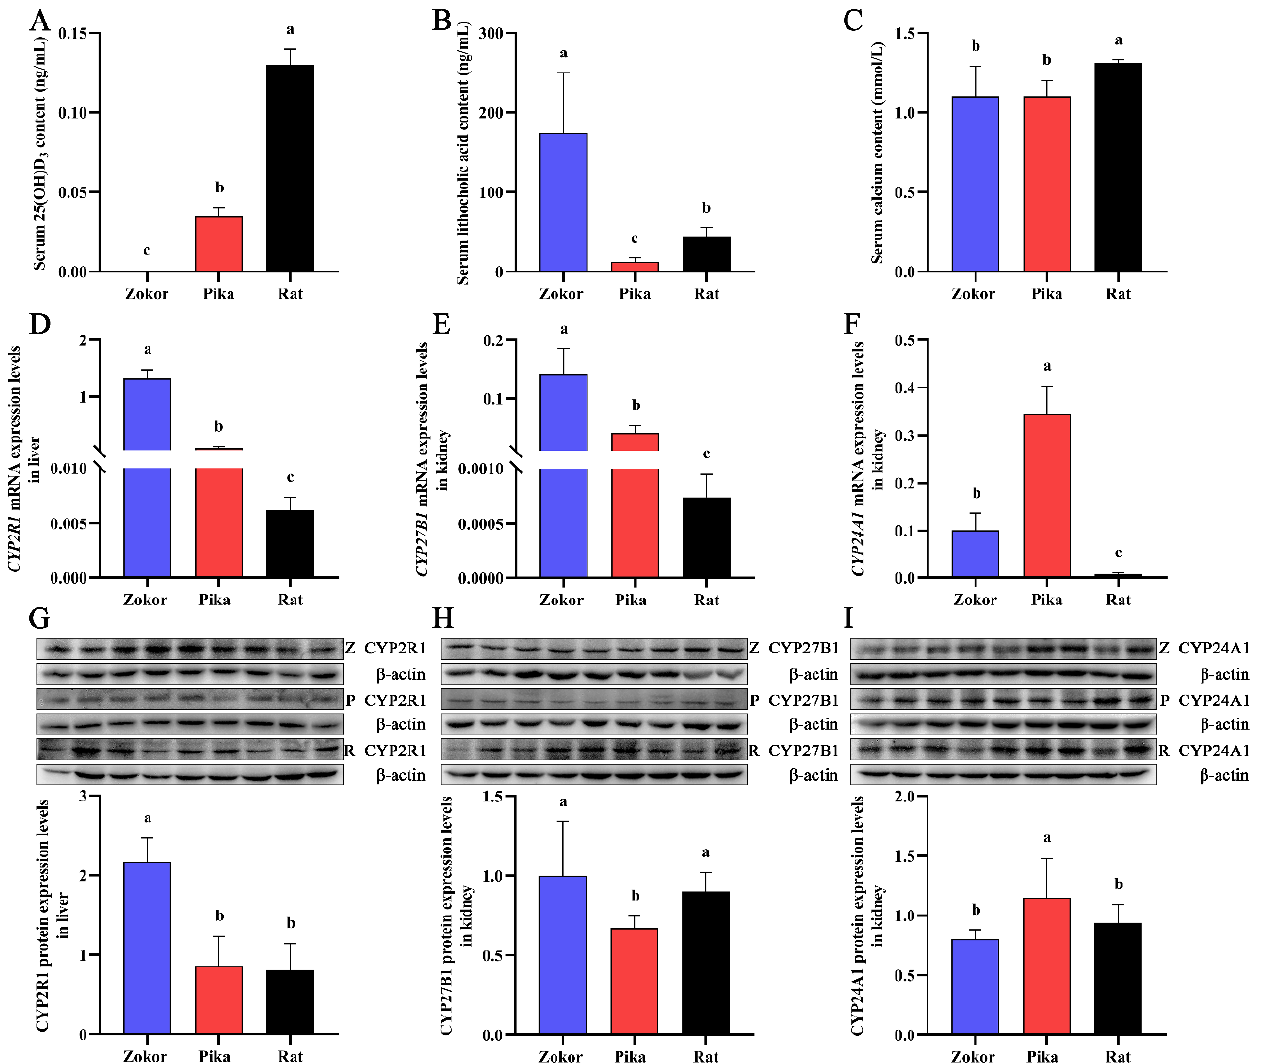
Figure 1. Serum levels of 25(OH)D 3 , lithocholic acid, and calcium and the expression levels of CYP2R1, CYP27B1, and CYP24A1 in the liver and kidney of plateau zokor, plateau pika, and Sprague-Dawley (SD) rats. ( A – C ) represent the serum levels of 25(OH)D 3 , lithocholic acid, and calcium, respectively. The mRNA ( D ) and protein ( G ) expression levels of CYP2R1 in the liver. The mRNA ( E ) and protein ( H ) expression levels of CYP27B1 in the kidney. The mRNA ( F ) and protein ( I ) expression levels of CYP24A1 in the kidney. Z, P, and R represent the plateau zokor at 3700 m elevation, plateau pika at 3700 m elevation, and SD rat at 1500 m elevation, respectively. Significant differences among species are represented by different lowercase letters ( p < 0.05). No significant differences among species are represented by the same lowercase letters ( p > 0.05). (original Western blot figures are in Figure